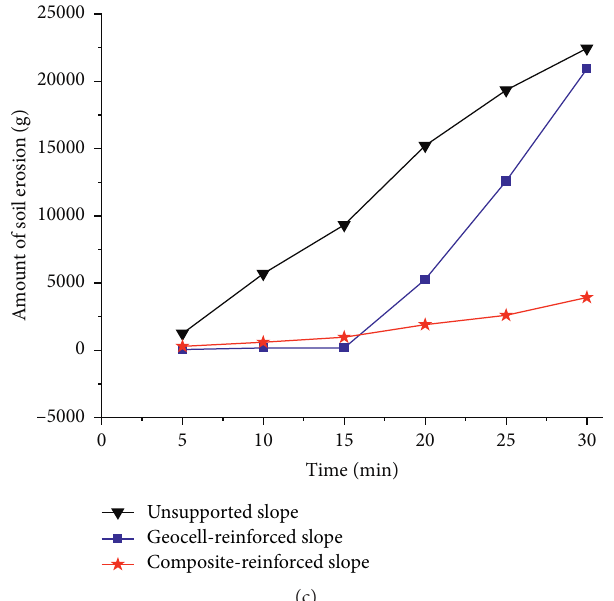
Figure 8: Amount of erosion soil during rainfall: (a) rainfall intensity: 50mm/h; (b) rainfall intensity: 75 mm/h; (c) rainfall intensity: